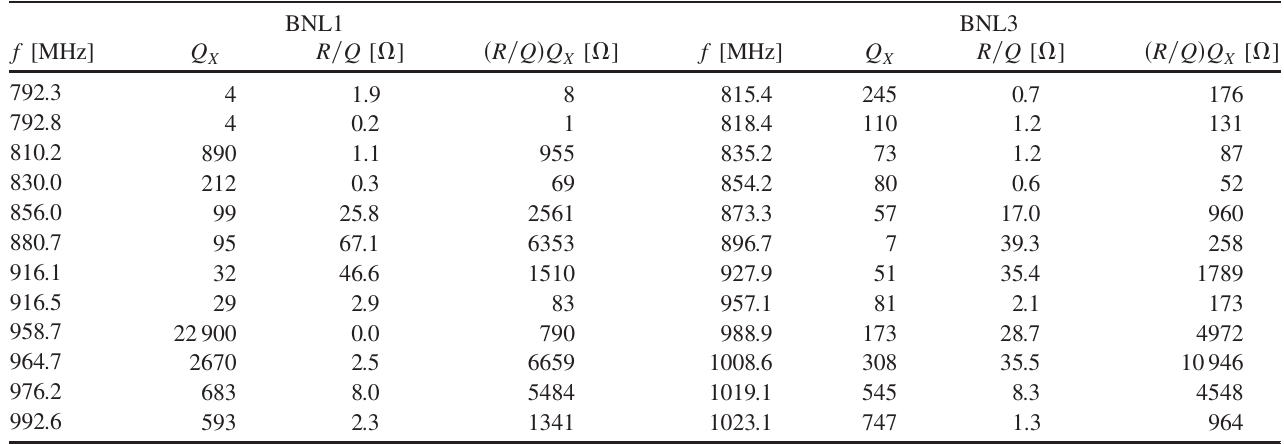
Fig. 16. Although only weak tails of these fields extend